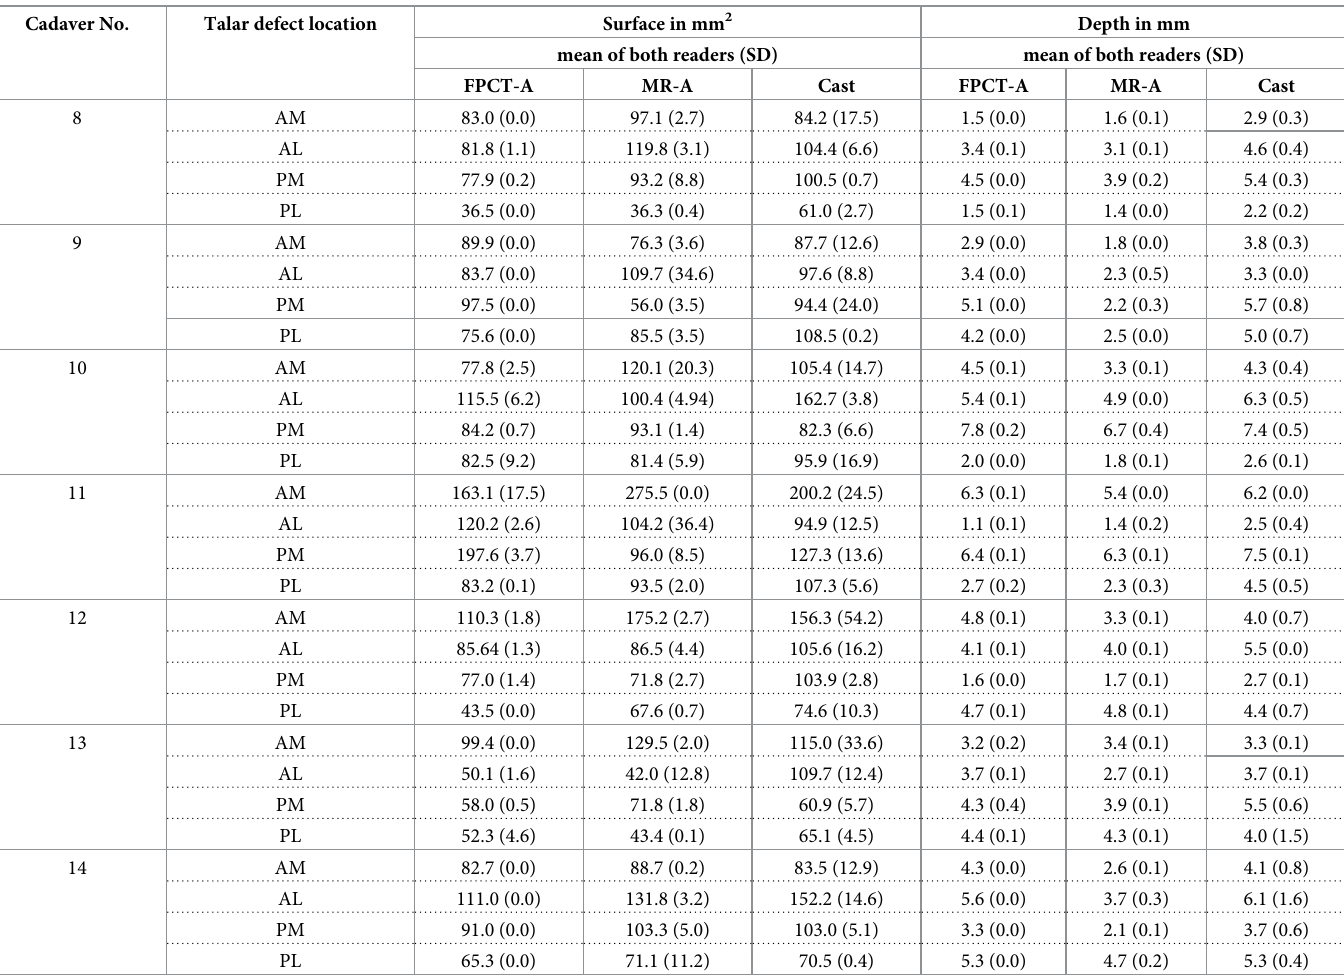
Table 3. Defect measurements cadavers 8–14. Cadaver No.